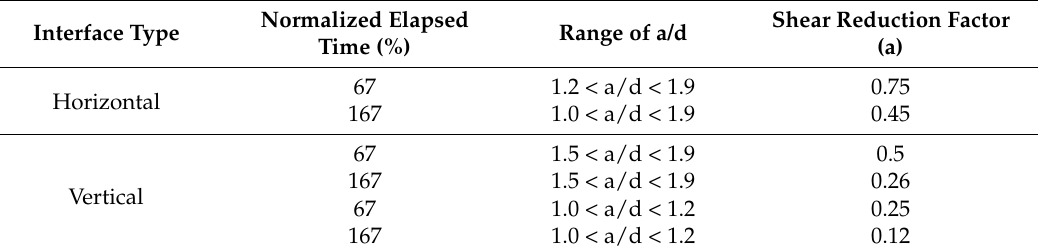
Table 6. Proposed shear reduction